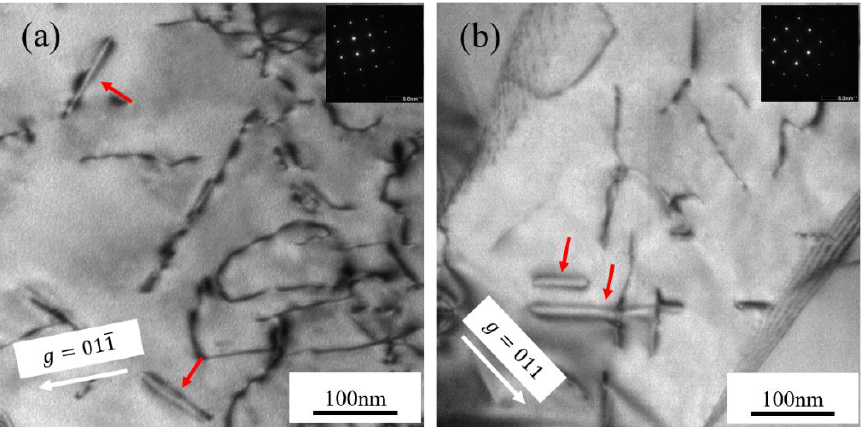
Figure 5. TEM bright-field micrographs showing the microstructure of the Fe-Cr alloys irradiated at 550°C. Red arrows indicate the loops with edge-on morphology: ( a ) Fe-9Cr imaged along the (100) zone axis; ( b ) Fe-9Cr-C imaged along the (100) zone axis.